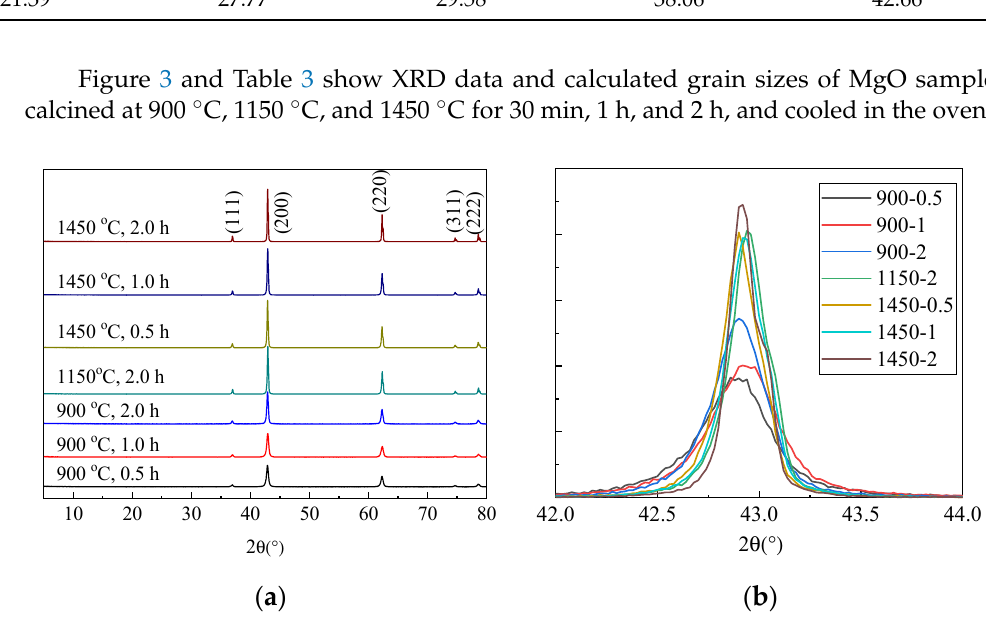
Figure 3. XRD patterns of MgO calcined under different temperatures and cooled in the oven: ( a ) 5–80 ◦ and ( b ) 42–44 ◦ . Table 3. Grain sizes of MgO calcined under different temperatures and cooled in the oven /nm.